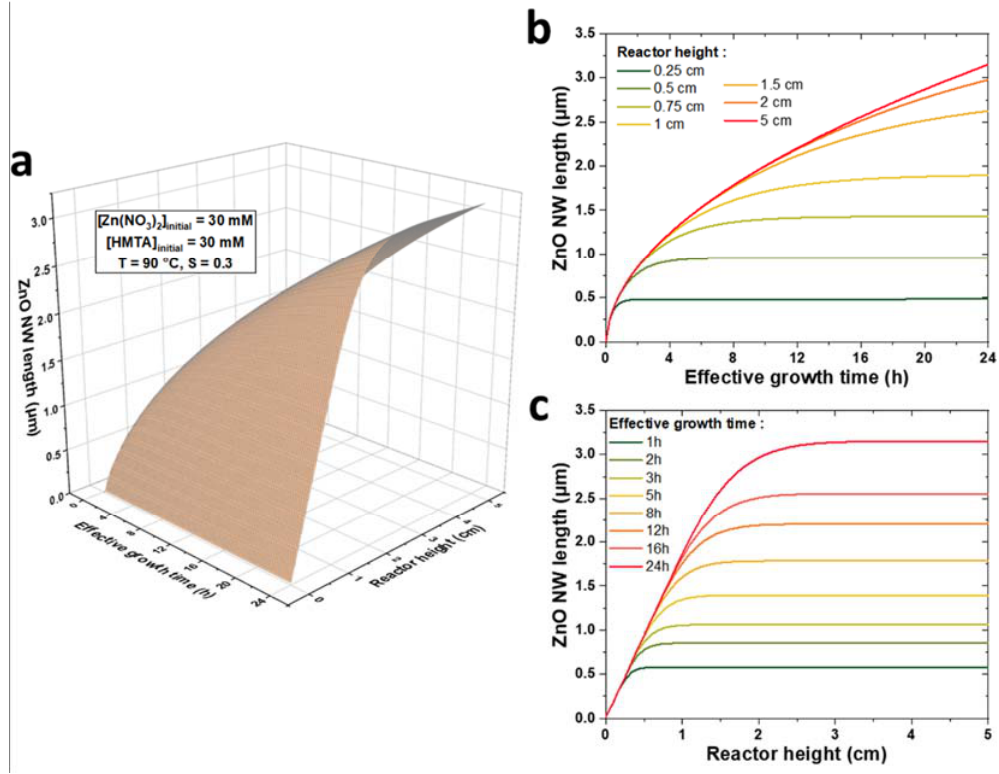
Figure 6. ( a ) 3D plot of the evolution of ZnO NW length vs. effective growth time, t, and reactor height, h, for a chemical bath kept at 90 °C initially containing 30 mM of Zn (NO 3 ) 2 and HMTA, as computed by the theoretical model using C 0 = 19.1 mM, C eq = 15.2 mM, k 1 = 18.2 μ m/s, S = 0.30, D = 2.74 × 10 − 9 m 2 /s, and ρ = 4.20 × 10 28 m − 3 . Two-dimensional plots of ZnO NW length vs. ( b ) effective growth time, t, for specific h values and ( c ) reactor height, h, vs. specific t values